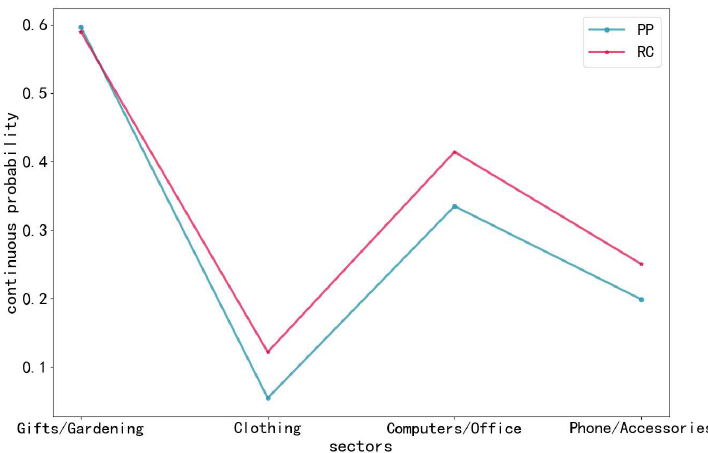
Figure A10. Continuous probability for PP time and RC time in a day of identified buyers. The x -axis represents four sectors in our dataset, and the y -axis is the continuous probability. Moreover, it can be seen that the continuous probability for RC time is often larger than that for PP